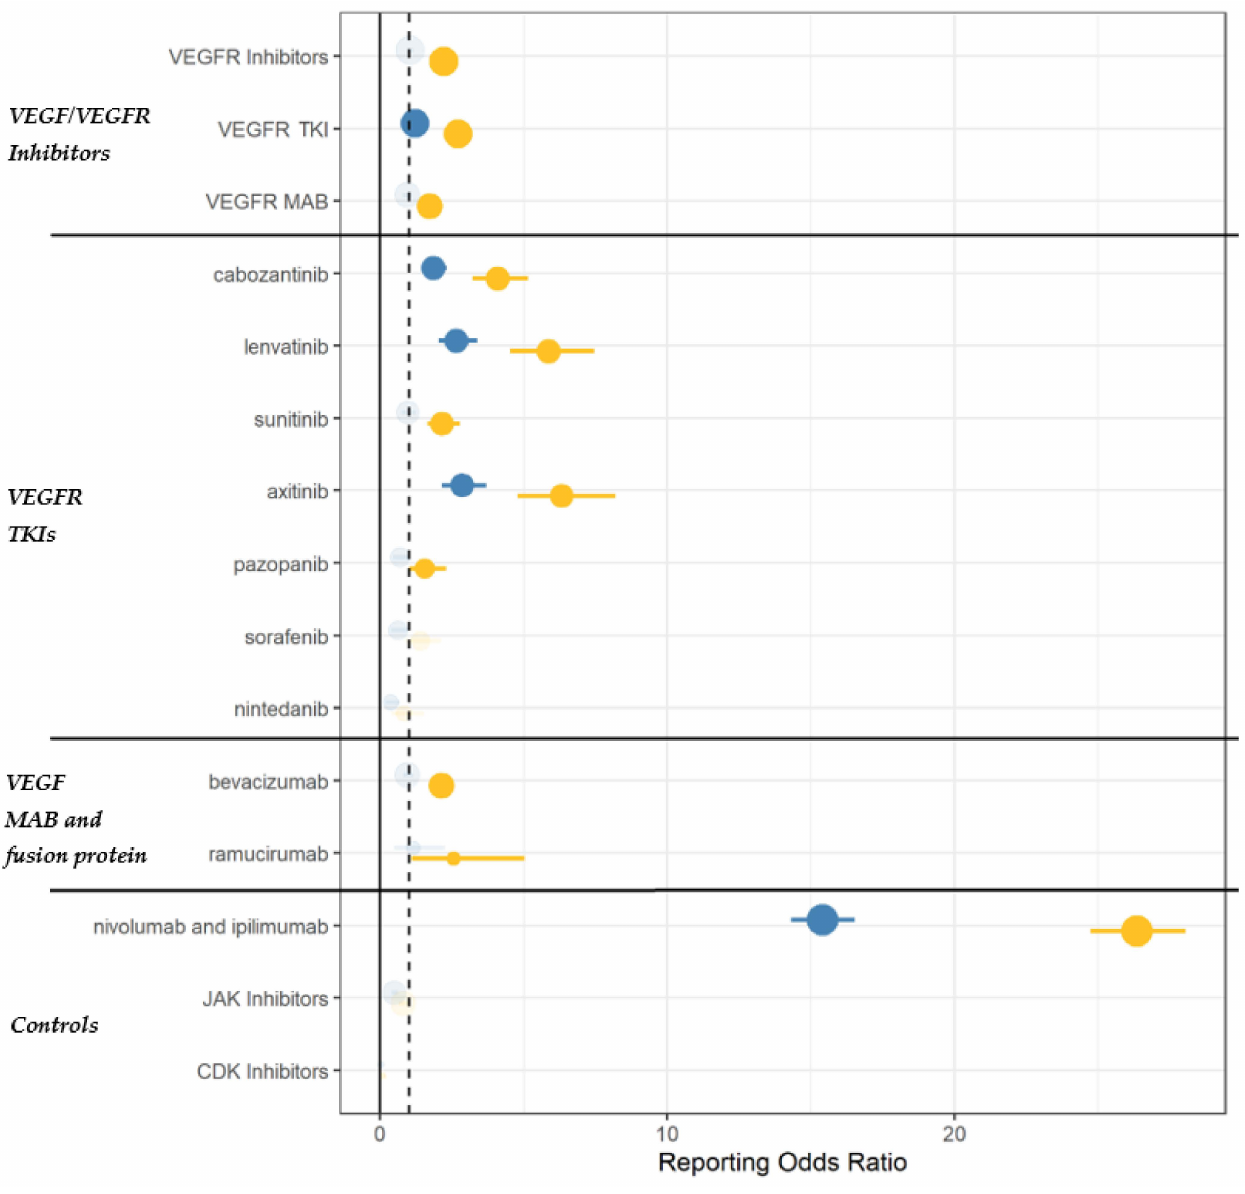
Figure 1. Disproportionality analysis through the Reporting Odds Ratios (RORs). Yellow and blue dots represent ROR estimates that were calculated using all drugs in the database, and anticancer drugs as a comparator, respectively. Estimates are proportional to the number of cases. VEGFR: vascular endothelial growth factor receptor; TKI: tyrosine kinase inhibitors; MAB: monoclonal